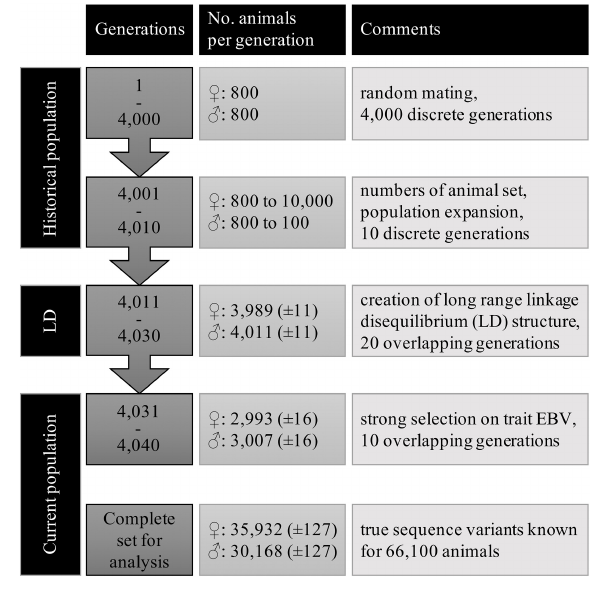
FIGURE 1 | Structure and number of animals of the simulated